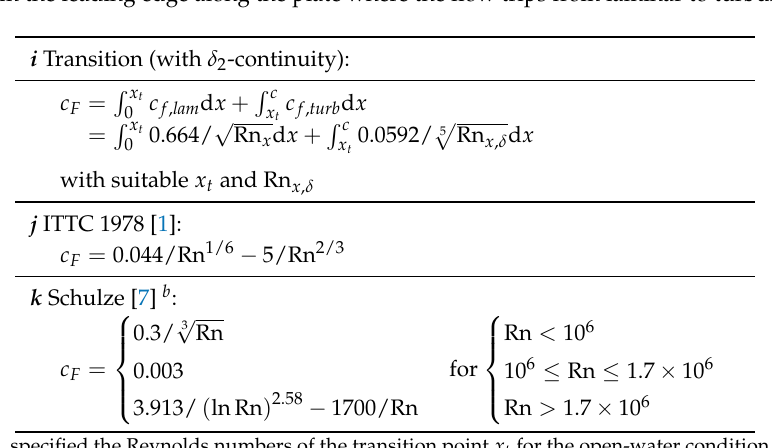
Table 2. Exemplary values for the viscous drag c F of a flat plate mentioned in the literature. x t is the position from the leading edge along the plate where the flow trips from laminar to turbulent a